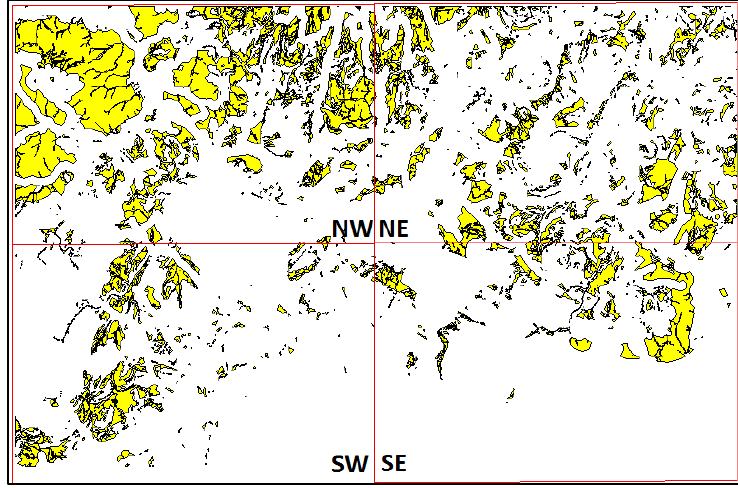
Figure 4. Distribution of woodland planting sites in the study area .